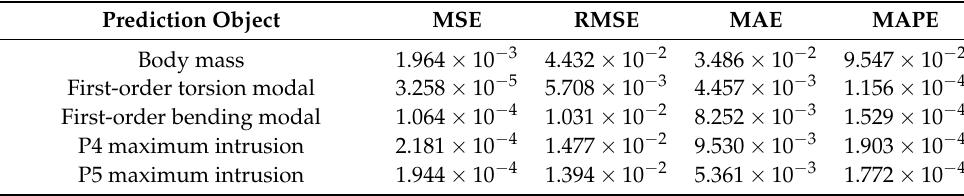
Table 5. Elman neural network algorithm prediction